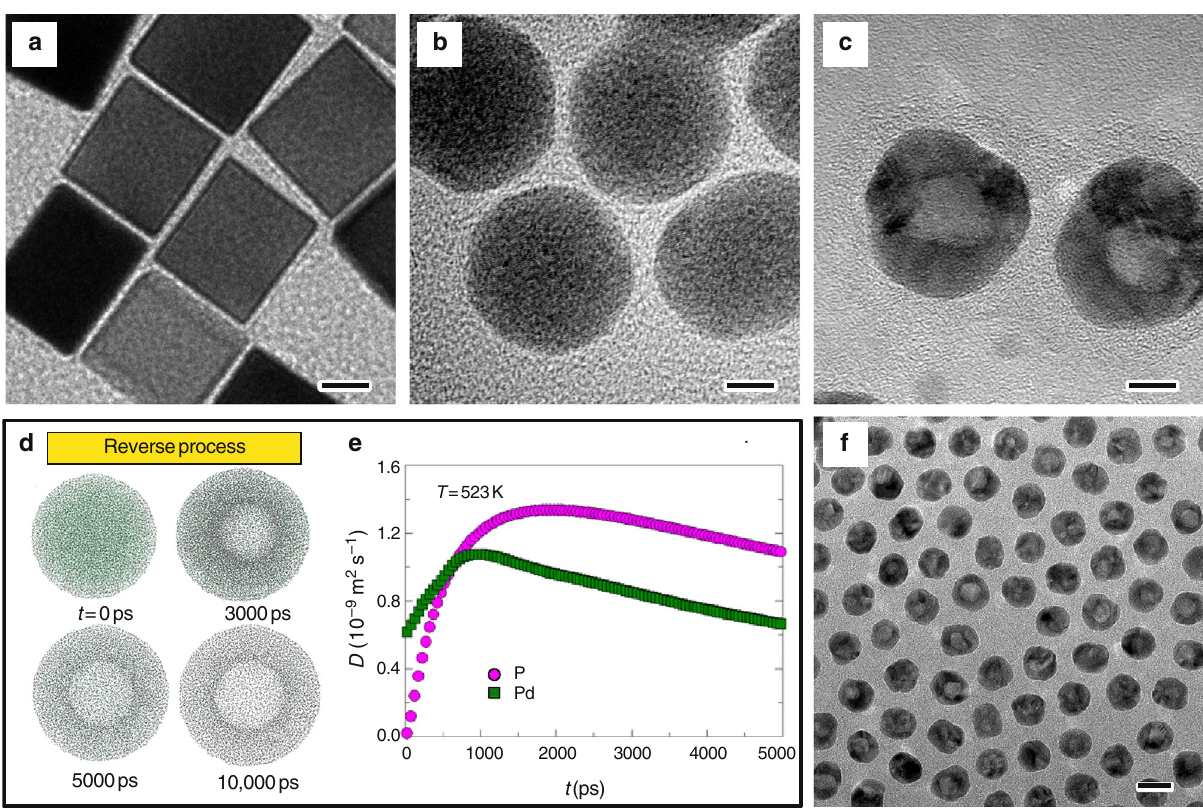
Fig. 2 Transformation of solid Pd nanocubes into Pd hollow nanocrystals with hollow interiors. a – c TEM images of Pd nanocubes, Pd-P intermediates, and hollow Pd nanospheres, respectively. Scale bars in a – c are 5 nm. d Snapshots of a Pd nanocrystal at different simulation time. e Instantaneous diffusion coef fi cients D of Pd and P atoms during the simulation. f TEM images of hollow Pd nanospheres at a low magni fi cation. Scale bar in f is 20